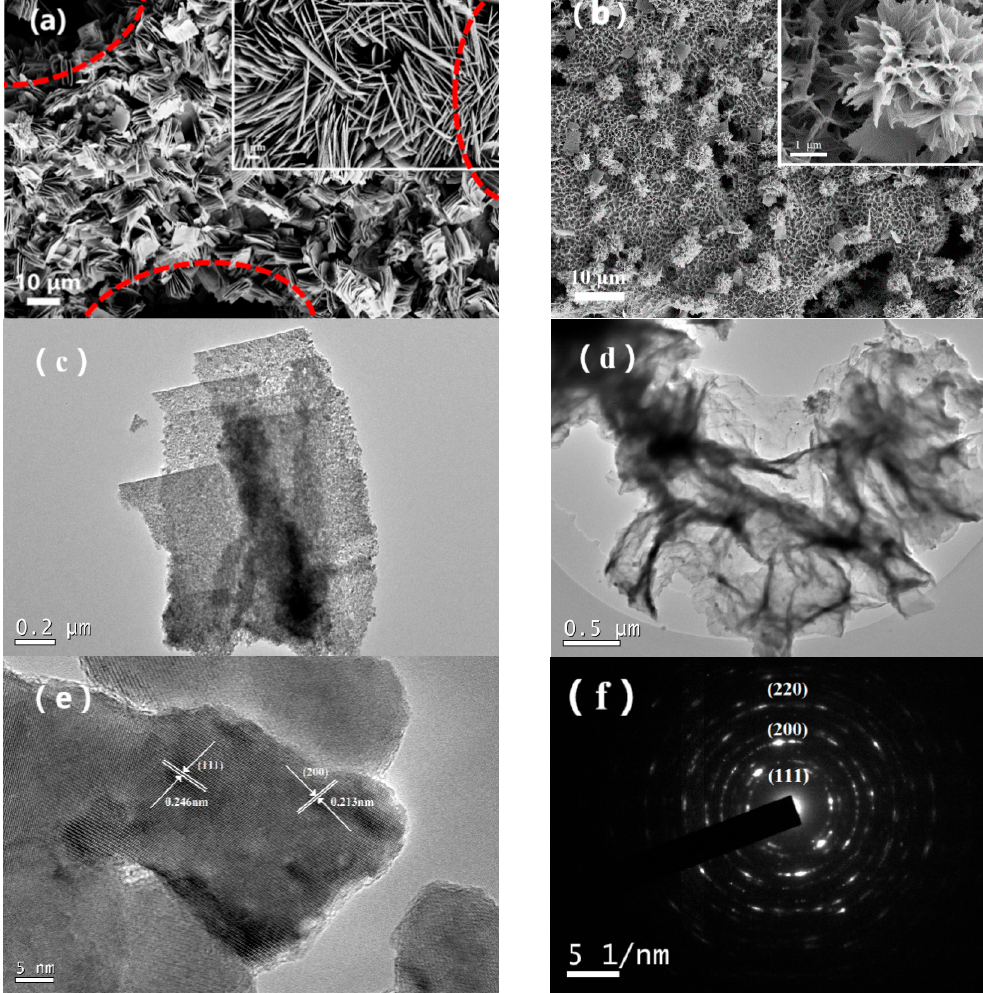
Figure 3. SEM images of CoO-NFs ( a ) and CoO-FLs ( b ); TEM images of CoO-NFs ( c ) and CoO-FLs ( d ); HRTEM image ( e ); and the selected area electron diffraction (SAED) pattern ( f ) of CoO-NFs.